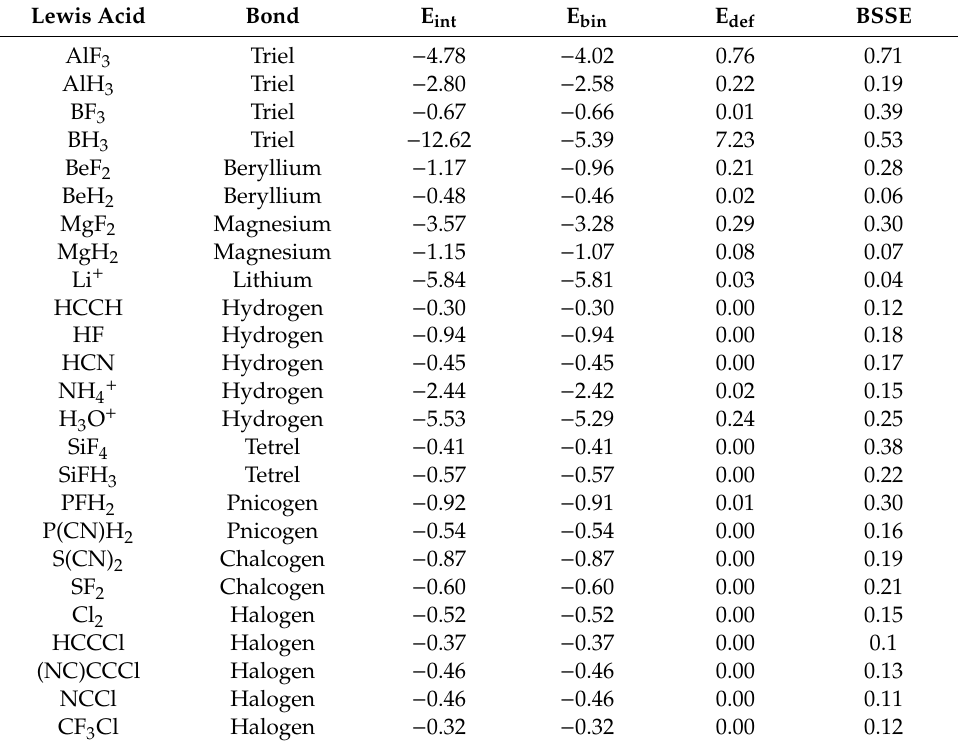
Table 1. The energetic characteristics of complexes analysed (in kcal / mol), the interaction and binding energy corrected for basis set superposition error (BSSE) (E int and E bin , respectively), the deformation energy (E def ), and the BSSE; the type of interaction is also indicated (Bond). The results of MP2 / aug-c-pVTZ calculations, i.e., second-order Møller–Plesset perturbation theory (MP2) with the aug-cc-pVTZ basis set are presented, the same level calculations are shown in other tables. Lewis